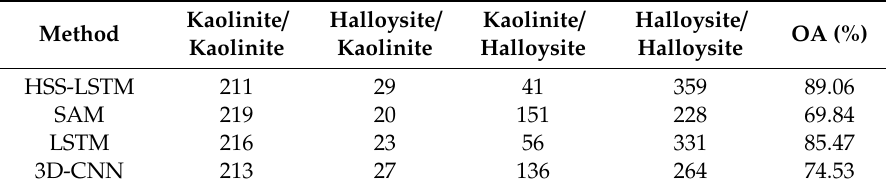
Table 4. Identification results of halloysite and kaolinite on testing samples. A/B denotes that the identification result is A, while the ground truth is B.